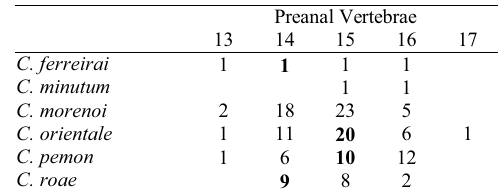
Table 5. Number of specimens of the species of Cetopsidium with cited number of preanal vertebrae. Bold indicates values for holotype when examined.